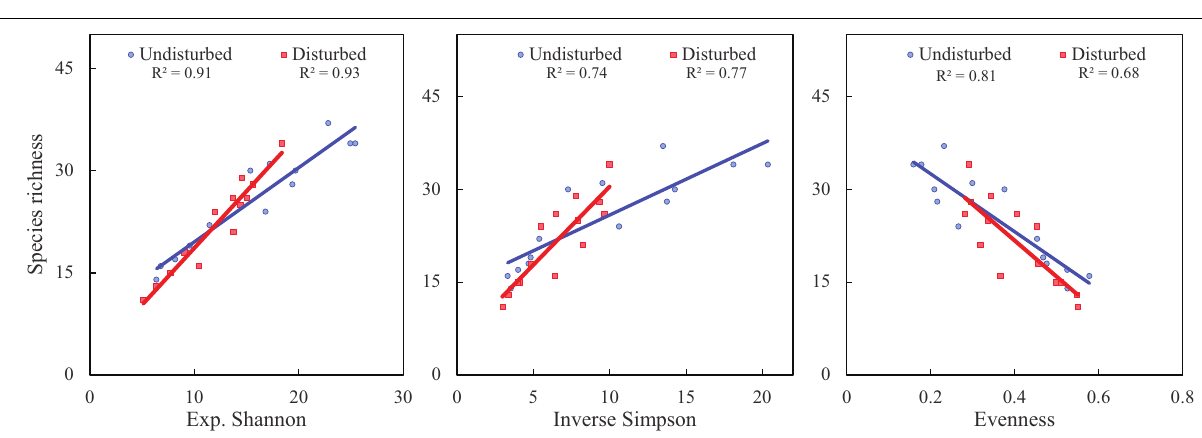
R² = 0.91 R² = 0.93